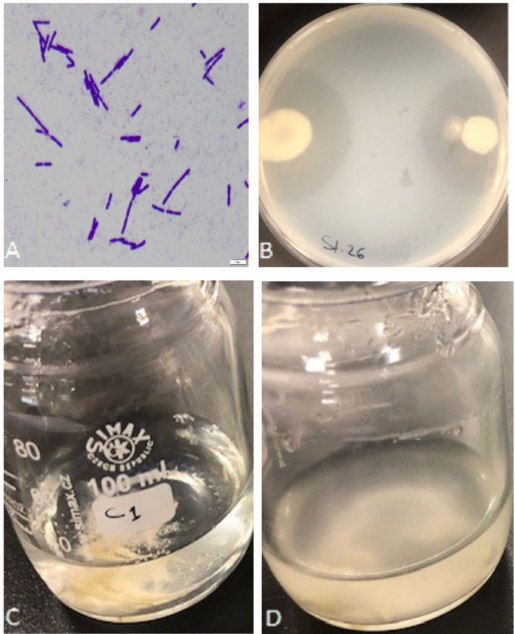
Figure 1. Isolation and screening of keratinolytic bacteria. ( A ) Bacterial isolates under the light microscope after gram staining. ( B ) Preliminary screening of isolate S26 for proteolytic activity on skim milk agar showing the formation of a clear zone around the colonies. ( C ) Growth medium before bacterium inoculation. ( D ) Feather degradation with bacterial isolate S1 after 72 h of shaking incubation at 37 ◦